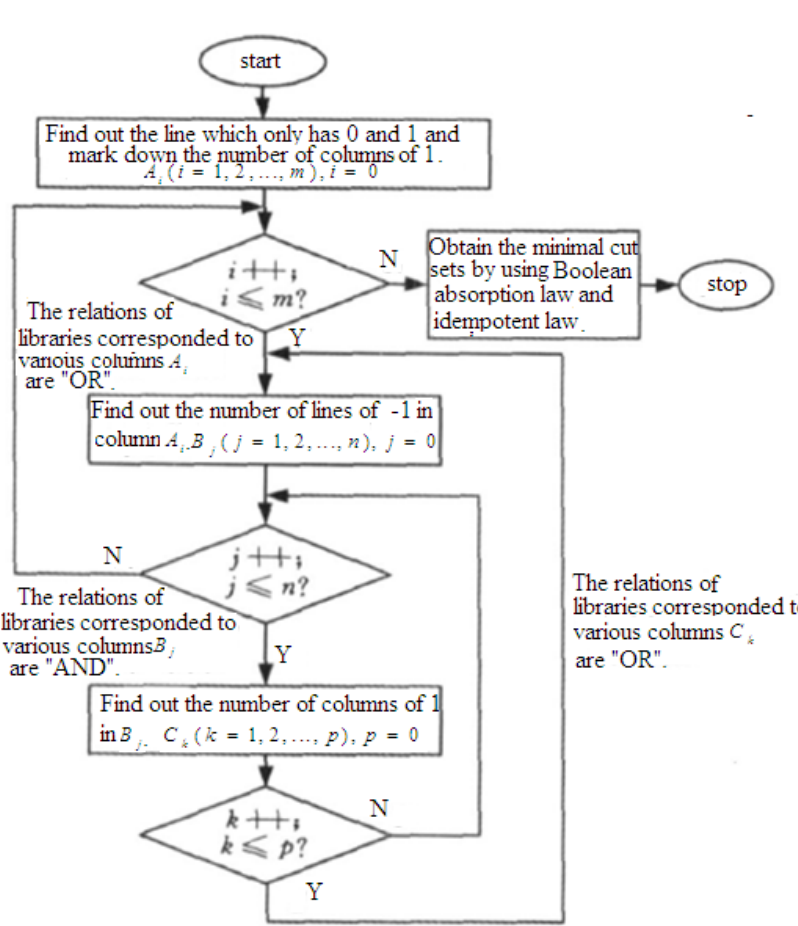
Figure 11. Program flow